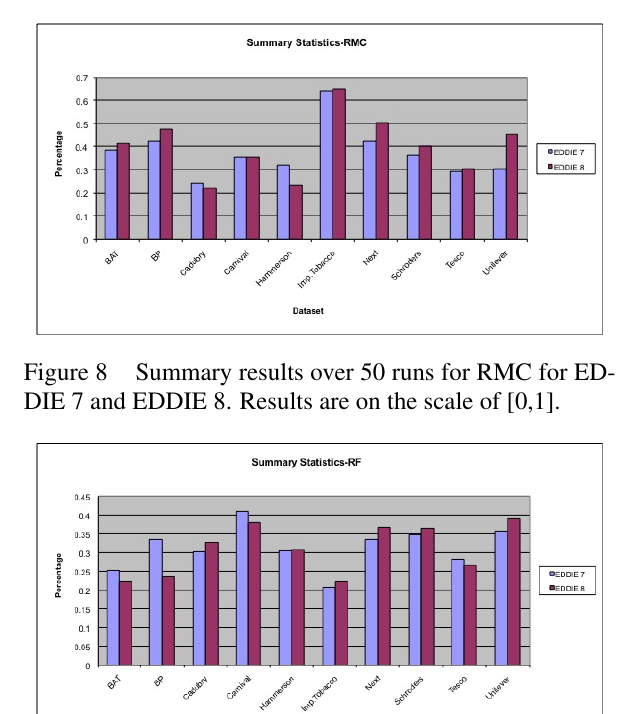
Figure 7 Summary results over 50 runs for RC for EDDIE 7 and EDDIE 8. Results are on the scale of [0,1].